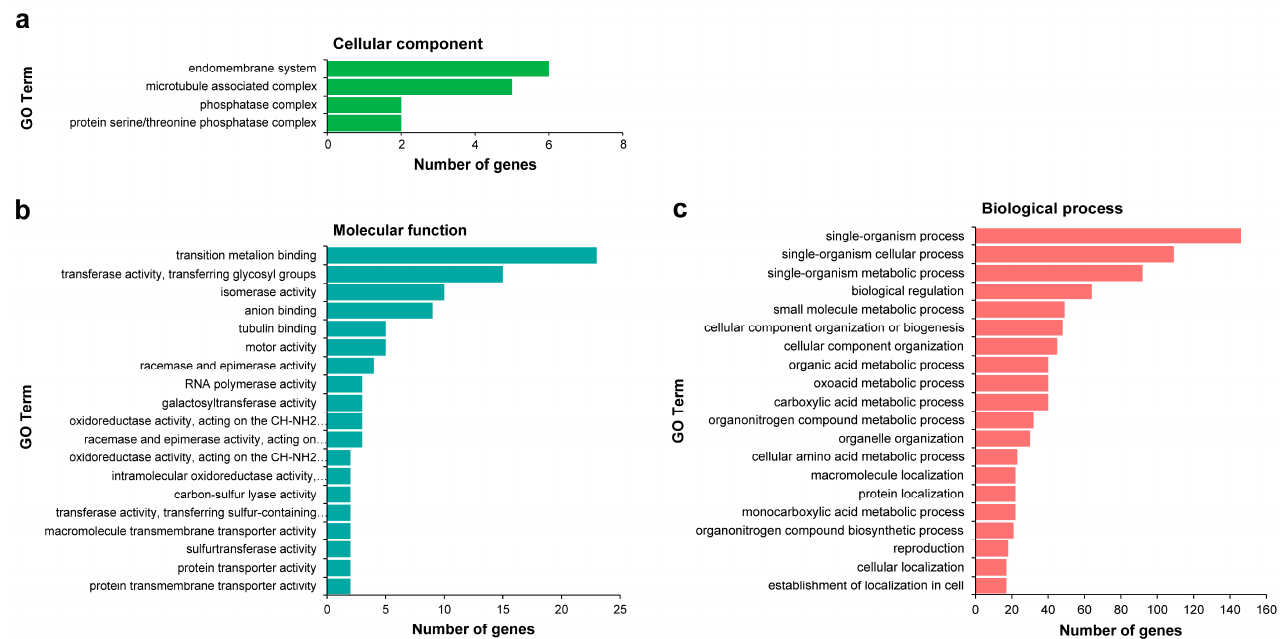
Figure 5. Gene Ontology (GO) enrichment analysis of differentially expressed miRNAs (DEMs) target genes. The figure shows significantly enriched GO terms ( p -value ≤ 0.05) in three categories: Cellular component ( a ), Molecular function ( b ), and Biological process ( c ). All of the GO terms are contained in ( a , b ); the twenty most dominant GO terms are contained in ( c ). GO analysis was performed with the GOseq R package. The results were visualized on level